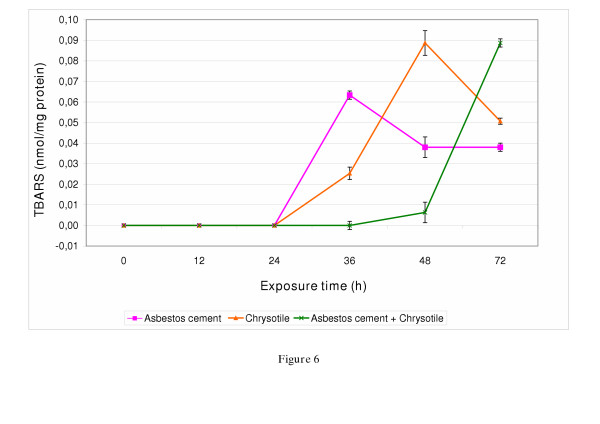
Thiobarbituric acid-reactive substances (TBARS) released by V79-cells exposed to asbestos-cement (3 μg/cm2), chrysotile (1 μg/cm2) or asbestos cement and chrysotile in co-exposure. The experiment was repeated twice. Significance: * p < 0.05